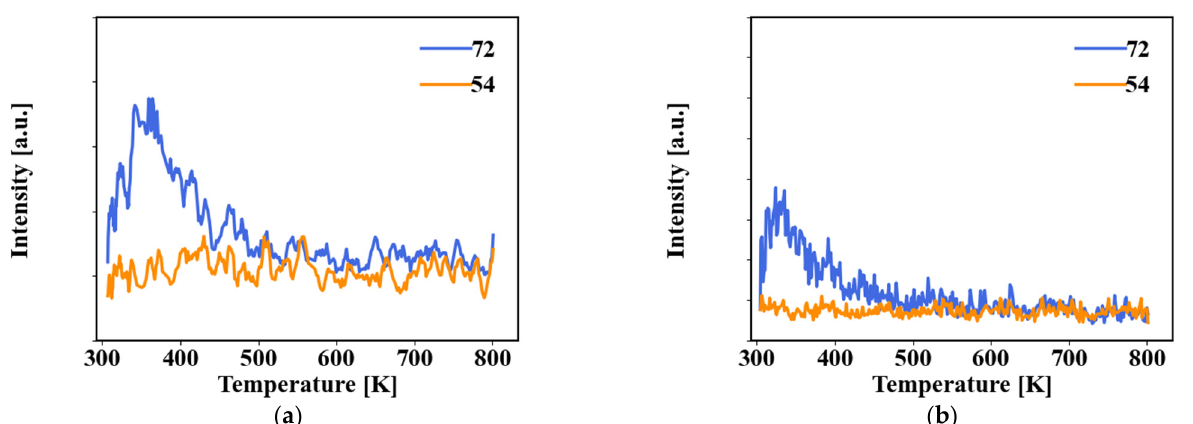
Figure 5. TPD of THF on ( a ) Y-ZrO 2 (100) and ( b )Y-ZrO 2 (110): THF-m/e = 72; 1,3-butadiene-m/e = 54.